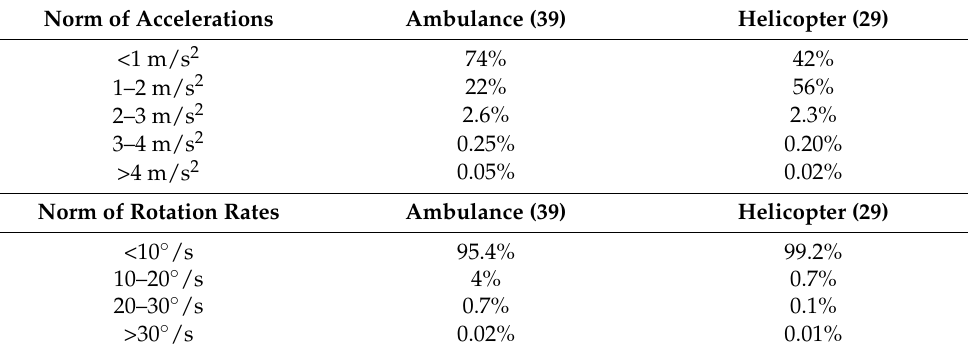
Table 3. Comparative acceleration and rotation rate levels in terms of percentage of time spent .